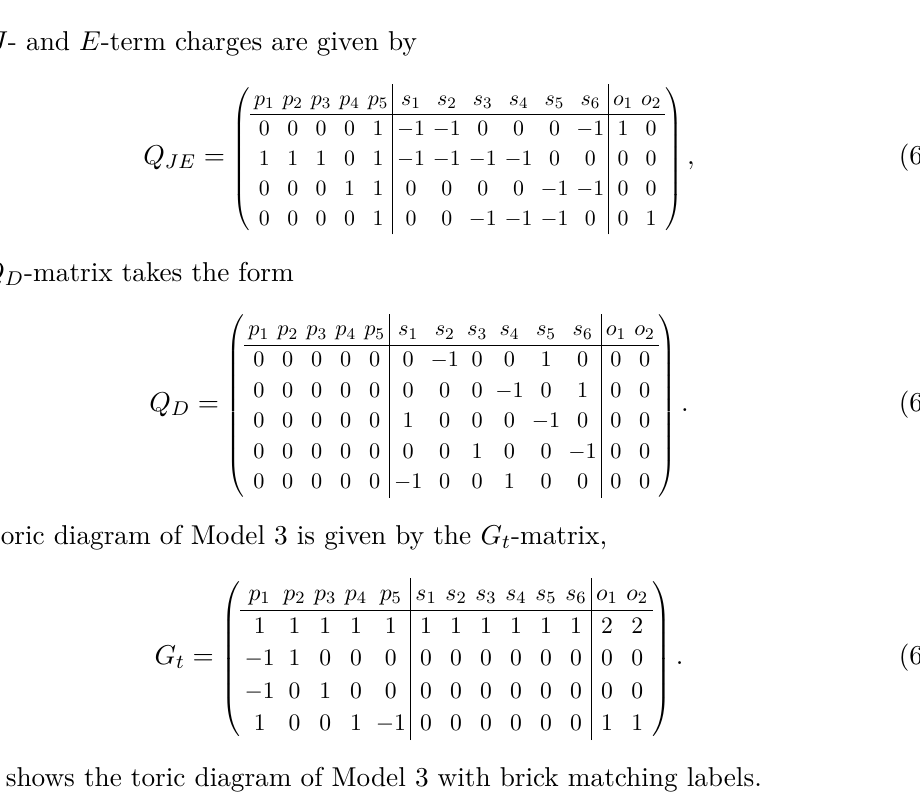
Figure 15 . Toric diagram for Model